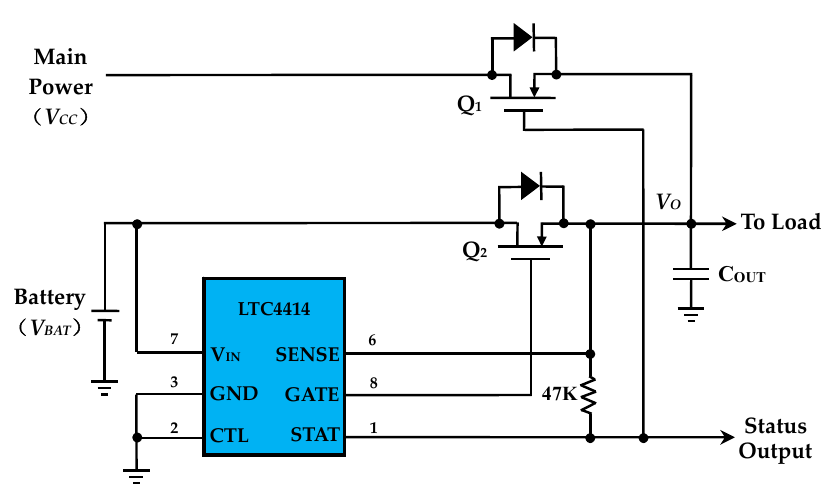
Figure 5. Typical application circuit of LTC4414. Source: Linear Technology Corporation.